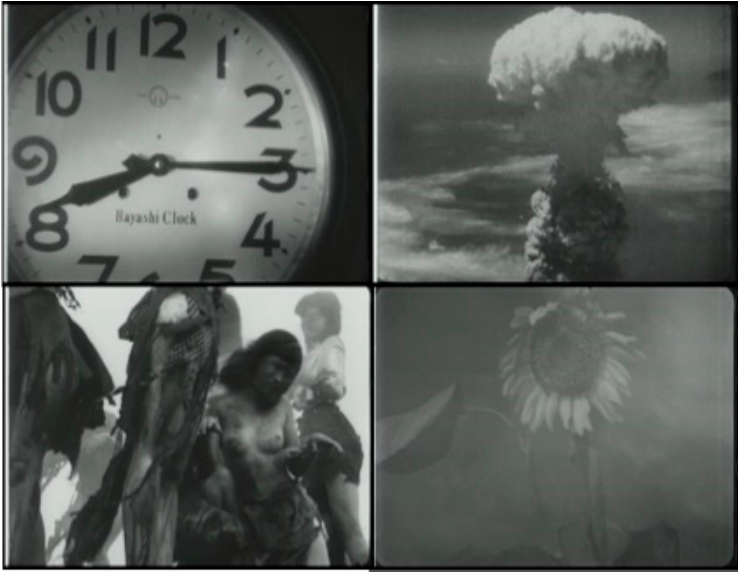
Figure 5. Children of Hiroshima (Shind ō Kaneto, 1952).